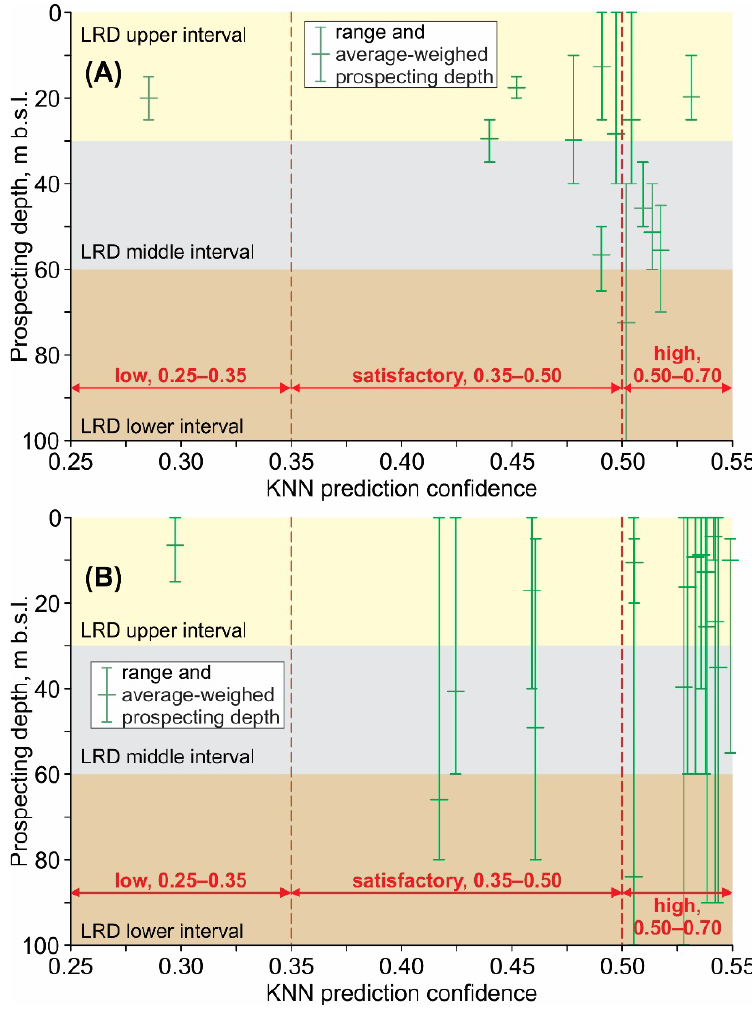
Figure 7. Range and average-weighed prospecting depth vs. average-weighed KNN prediction confidence for the 13 gravel ( A ) and 17 coarse sand ( B ) sedimentary bodies, as shown in Table 1. LRD stratigraphic interval as defined in Bullejos et al. [17] and achieved confidence levels, namely low (0.25 − 0.35), satisfactory (0.35 − 0.50) and high (0.50 − 0.70), are also indicated.